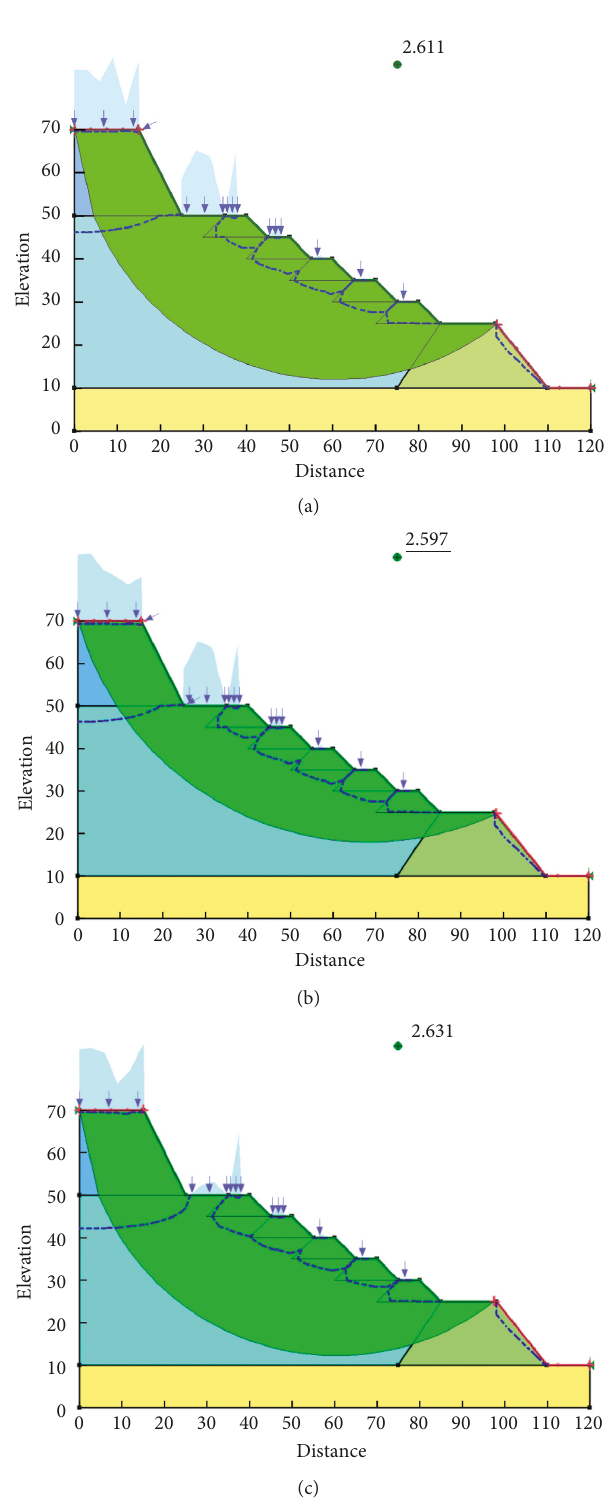
Figure 12: Stability coefficient of red mud stockpile under different rainfall conditions: (a) rainfall condition I, (b) rainfall condition II, and (c) rainfall condition sintering red mud is much higher than that of Bayer red mud, and the sensitivity of sintering red mud to rainfall is lower than that of Bayer red mud. The sintering red mud can